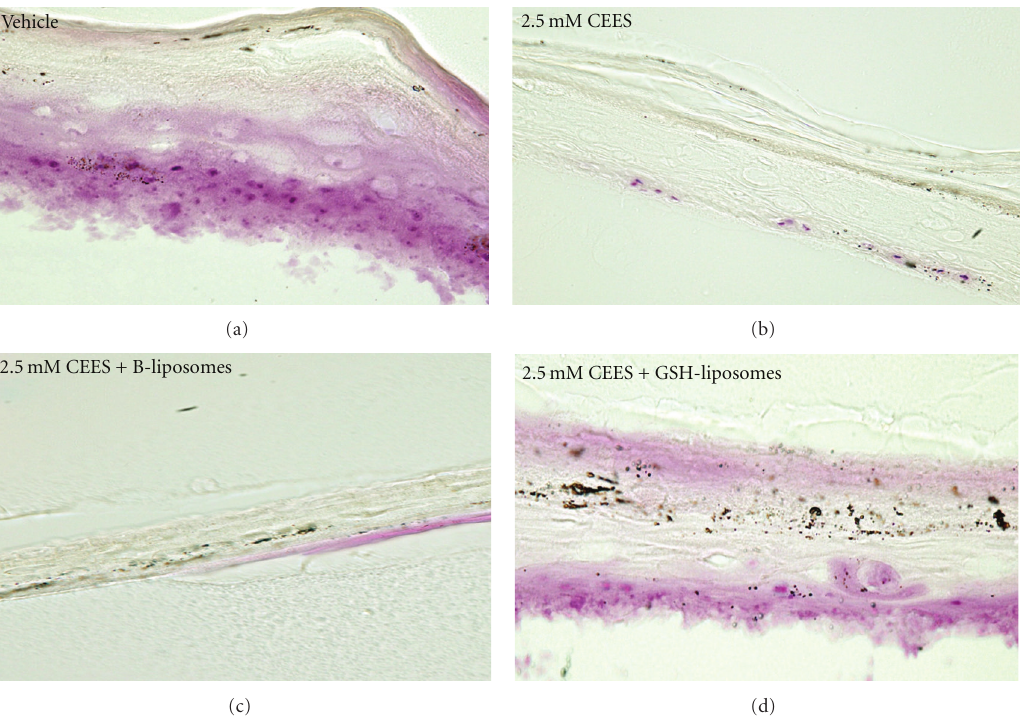
Figure 6: Protective e ff ect of GSH-liposomes in the EpiDerm model . EpiDerm tissues were topically exposed to vehicle (1% DMSO) or 2.5 mM CEES in the absence or presence of GSH-liposomes or Blank liposomes (B-liposomes). After the MTS assay EpiDerm tissues were frozen, dissected, and photographed under a light microscope with 400x magnification (see Section 2). Violet color reflects the accumulation of the MTS formazan product in the proliferating keratinocytes. Note the disruption of the keratin filament structure in the stratum corneum in the presence of CEES, and the increase of proliferating (violet) basal keratinocytes in the presence of